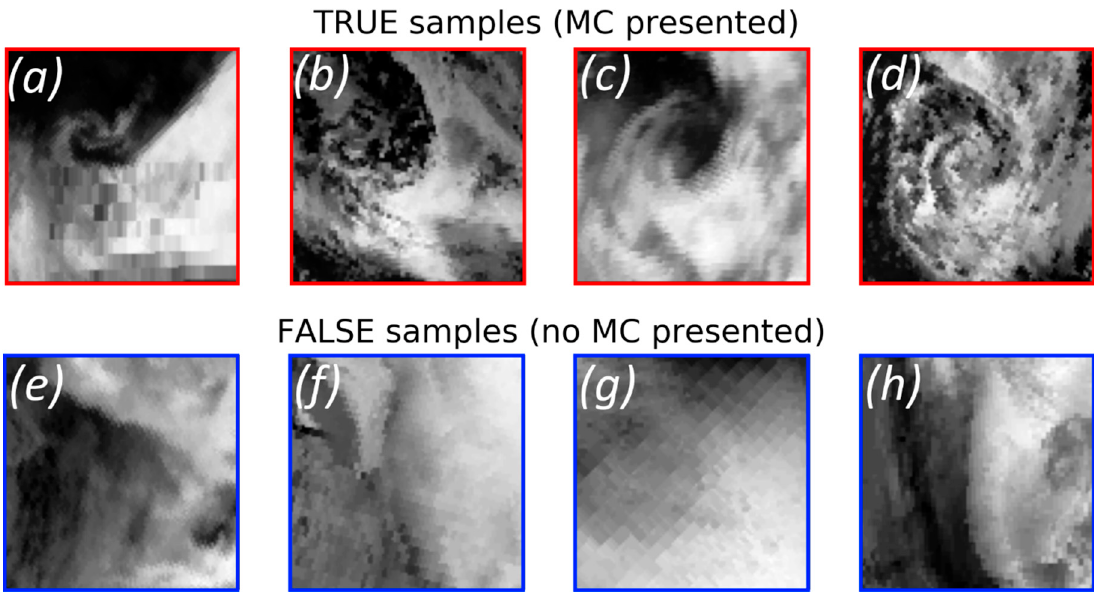
Figure 2. Examples (IR only) of true and false samples for DCNNs training and testing of DCNNs results assessment. 100 × 100 grid points (500 × 500 km) patches of IR mosaics for ( a – d ) true samples and false ( e – h ) samples.